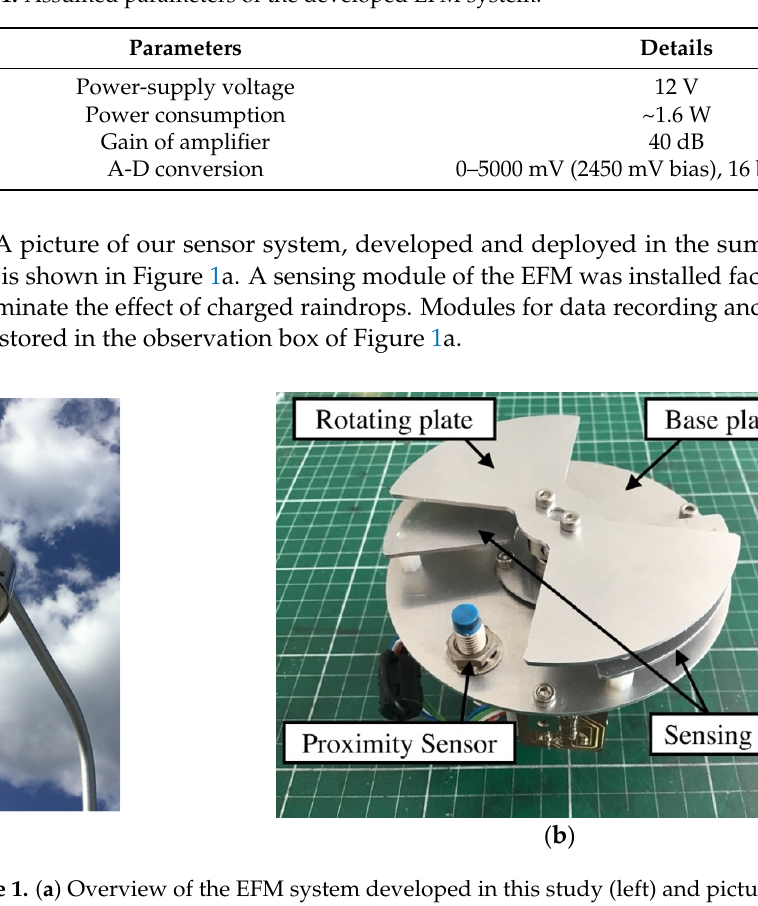
Table 1. Assumed parameters of the developed EFM system.